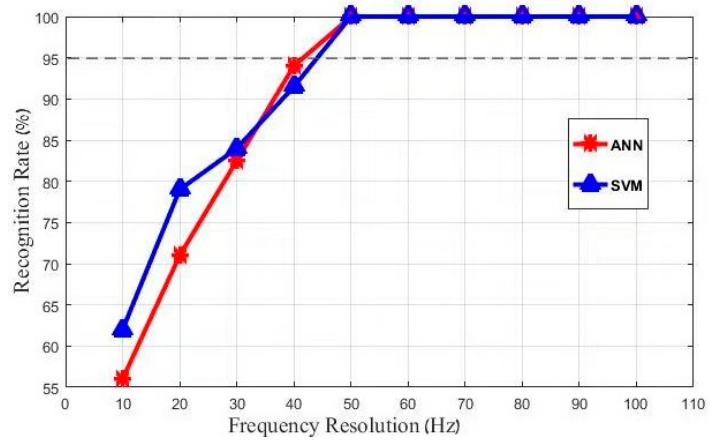
Figure 16. The recognition rate with different frequency resolution.